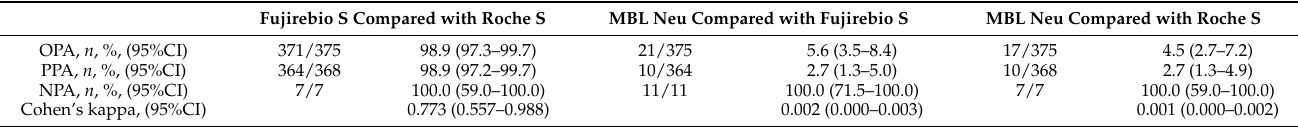
Table 3. Concordance between SARS-CoV-2 Ab detection assays.